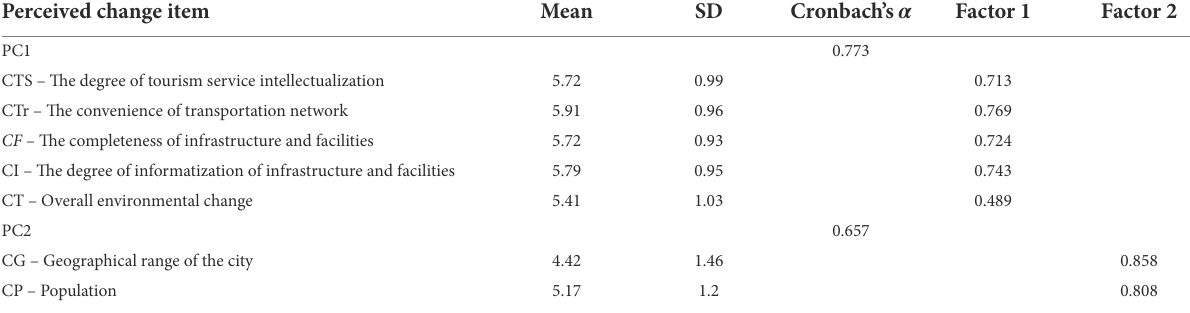
TABLE 2 Exploratory factor analysis results of perceived change